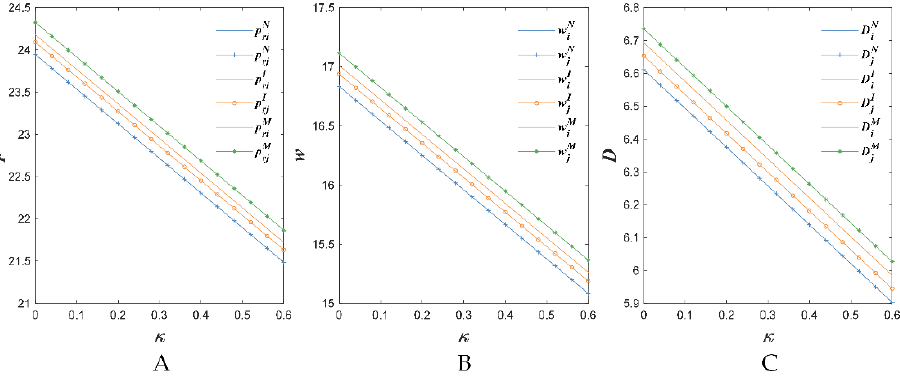
Figure 5. Quality safety perception coefficient’s impact on retail price ( A ), wholesale price ( B ) and demand ( C ).